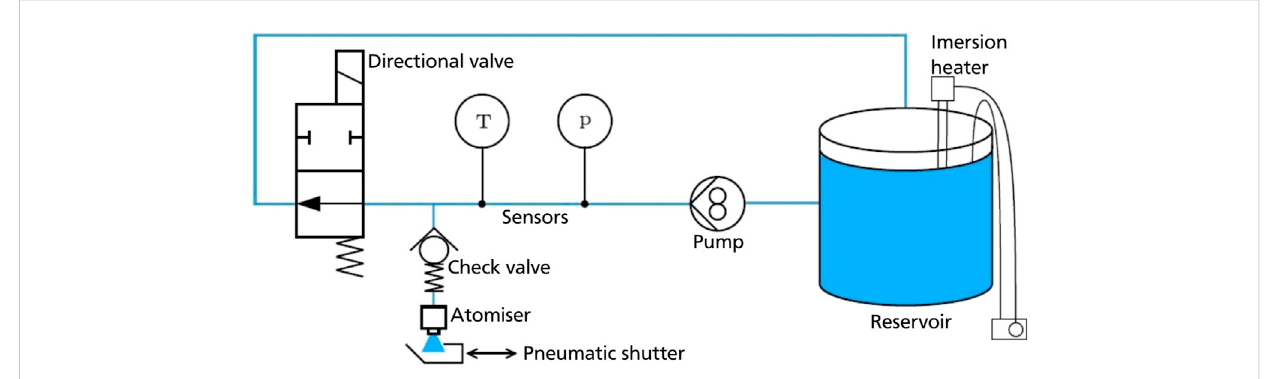
FIGURE 2 Scheme for the atomizer and water supply system used for spray generation